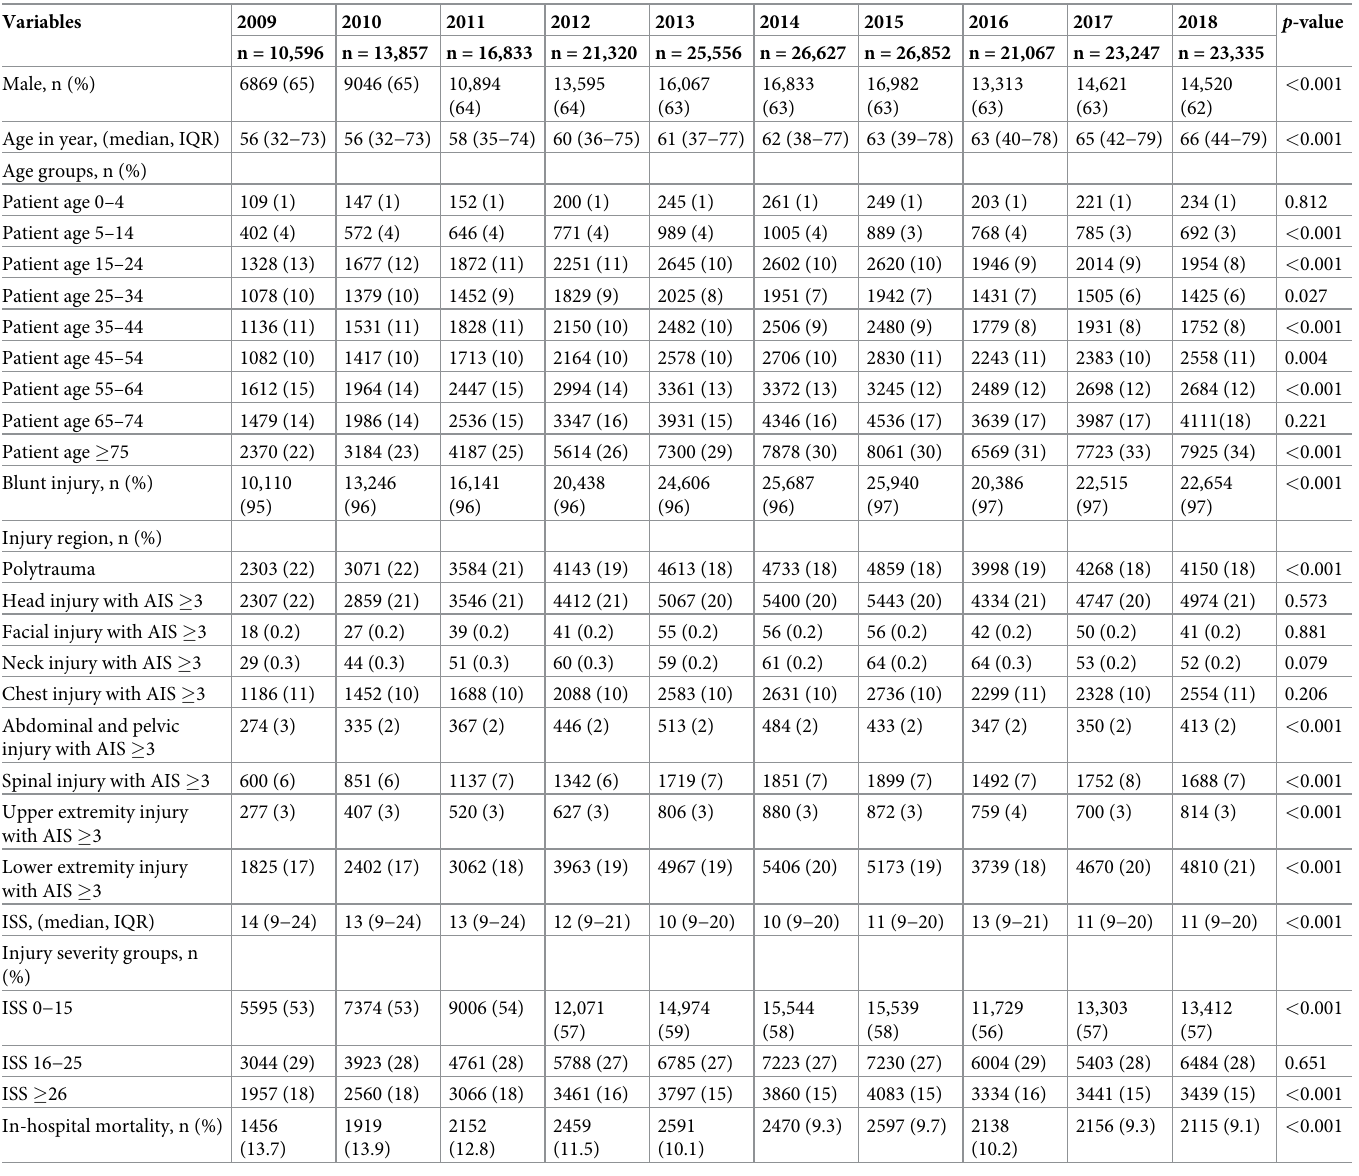
Table 1. Demographics and characteristics of injured patients by year